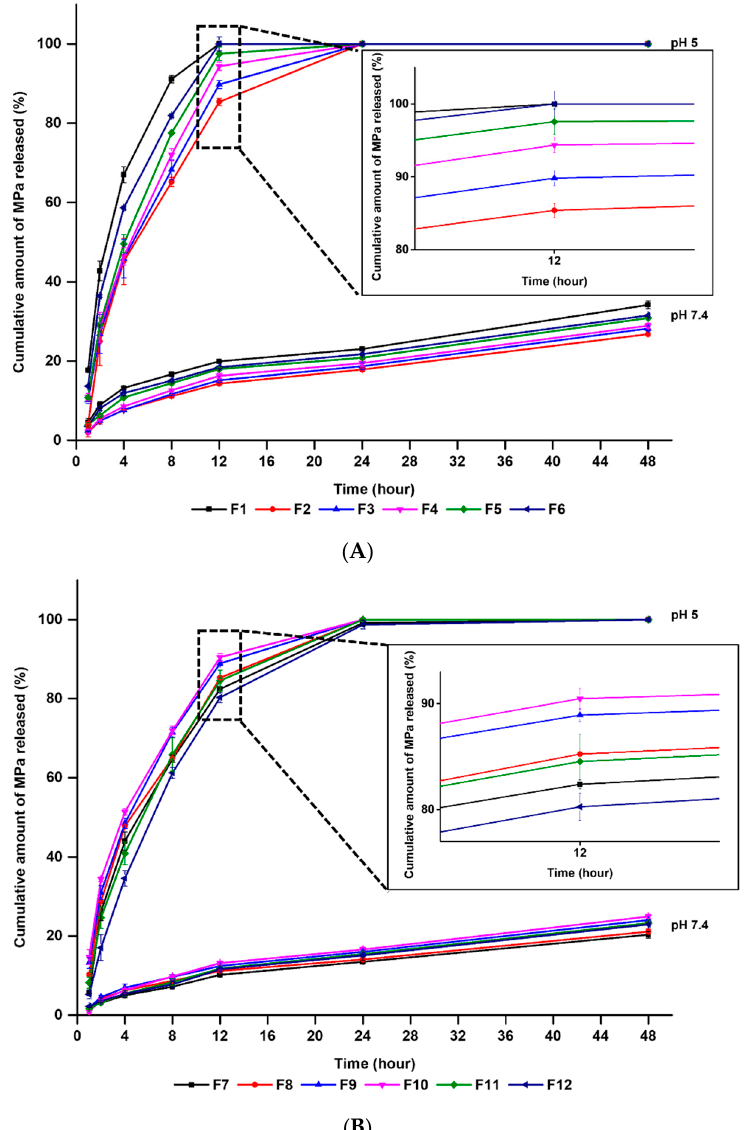
Figure 6. Cumulative percentage release profiles of methyl pheophorbide-a from nano-transfersomes that are (A) F1–F6 and (B) F7–F12 in release medium (pH 7.4 or pH 5), as determined using dialysis bag method. Results are expressed as the means ± standard errors of three independent experiments ( n = 3).